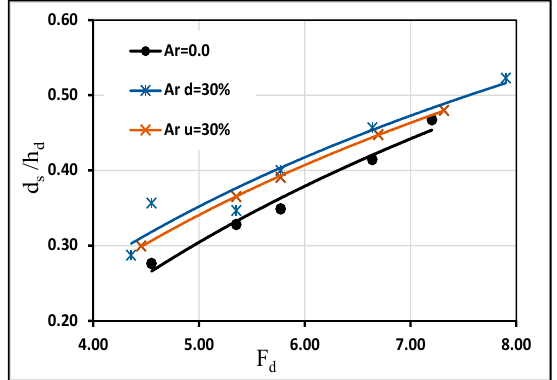
Figure 10. Relationship between (d s /h d ) and (F d ) at S = 1.06 and different Ar.